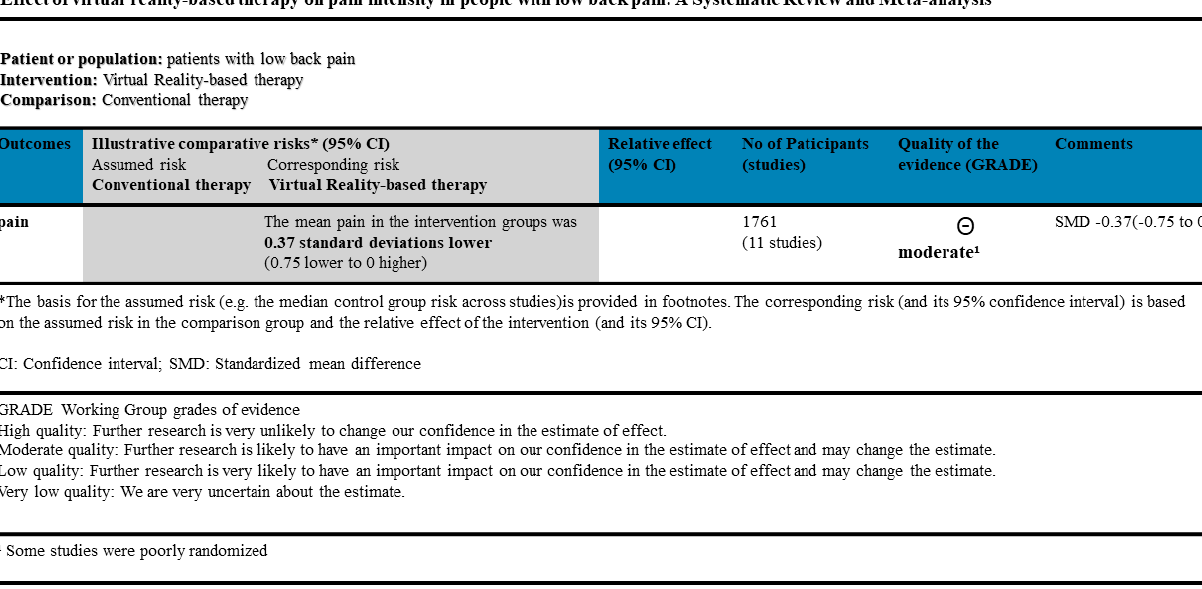
Figure 4. Summary of findings.